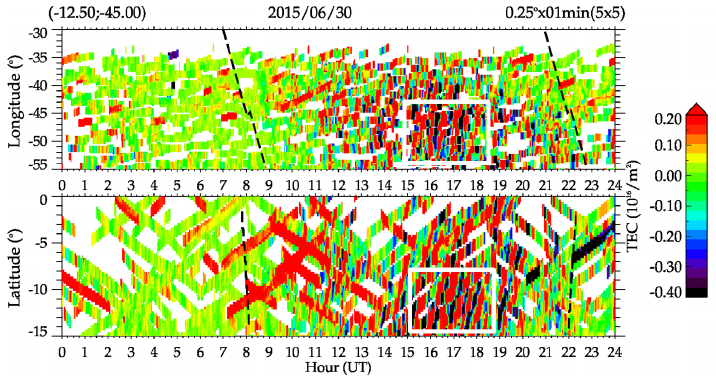
Figure 5. The keograms created from dTEC maps on 30 June 2015; longitudinal ( top ) and latitudinal ( bottom ). The black dashed lines indicate the dawn and dusk solar